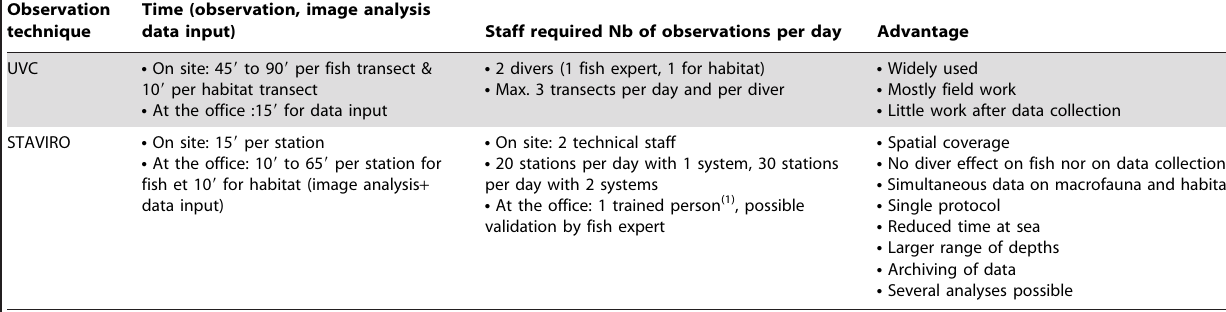
Table 6. Cost-effectiveness of UVC and STAVIRO